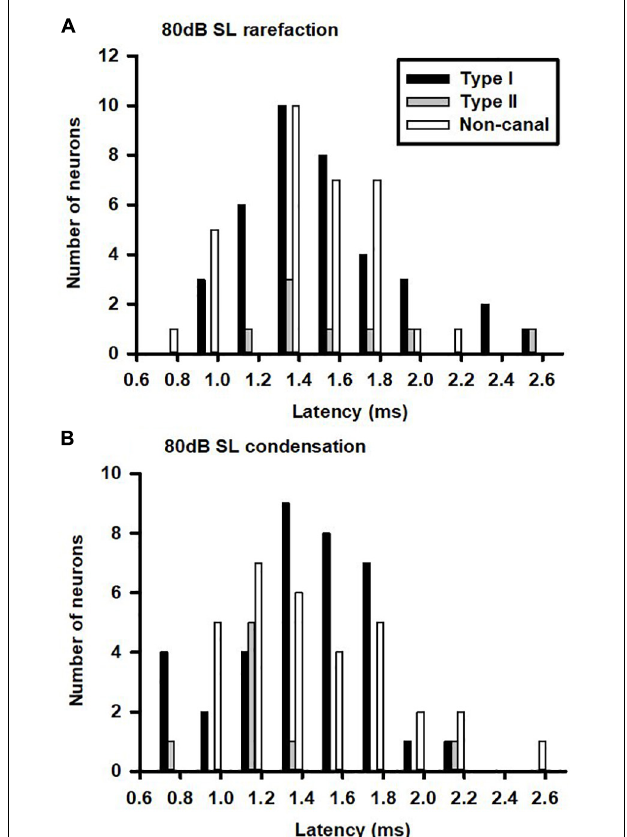
FIGURE 3 | Latency distributions of click-evoked responses in vestibular nucleus neurons. (A) Rarefaction and (B) condensation.